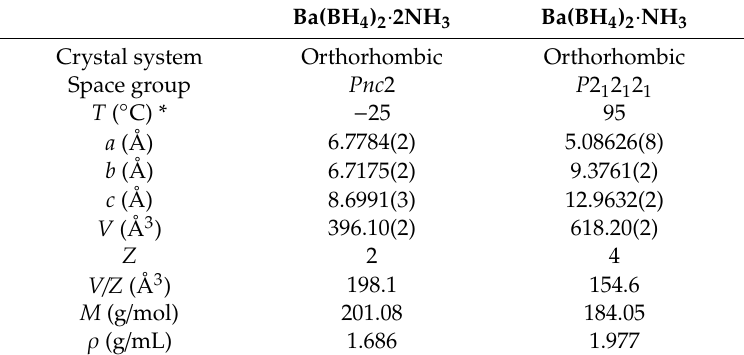
Table 2. Crystallographic data extracted by Rietveld refinement.